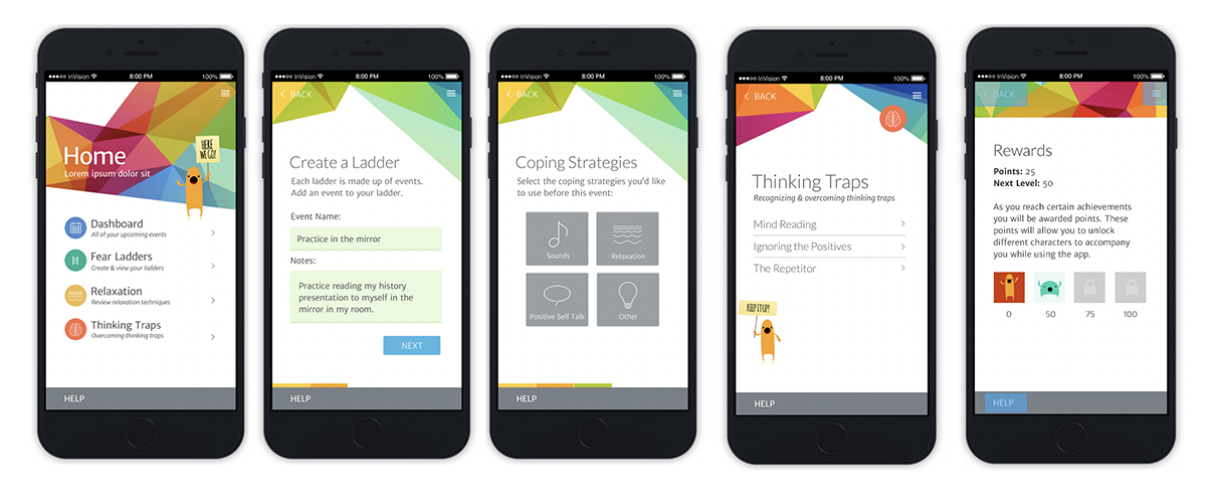
Figure 6. Screenshots of key content domains for